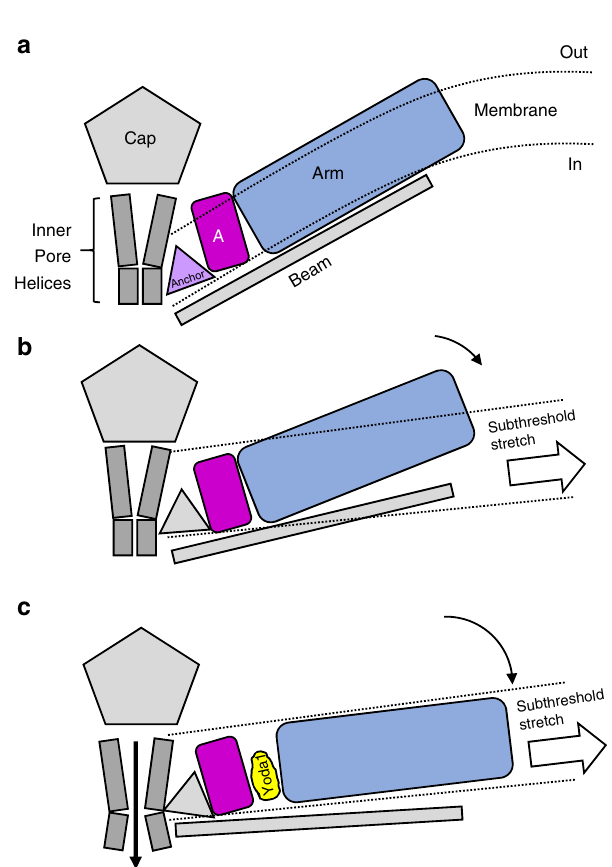
Fig. 6 A molecular wedge mechanism for Yoda1-mediated Piezo1 activation. a In absence of membrane tension, the Piezo1 arm (blue) is in a “ fl exed ” position (only one arm is represented for clarity). b In presence of a sub- threshold stimulus, the arm is slightly extended due to the fl attening of the lipid bilayer but not enough to open the pore. c By binding between Repeat A (magenta) and the N-terminal part of the arm, Yoda1 acts like a wedge by decoupling these two domains, hence increasing tension-induced arm extension. This wedge-like effect ultimately leads to channel opening in the presence of sub-threshold stimuli. The mechanism by which the lever motion opens the channel gate is